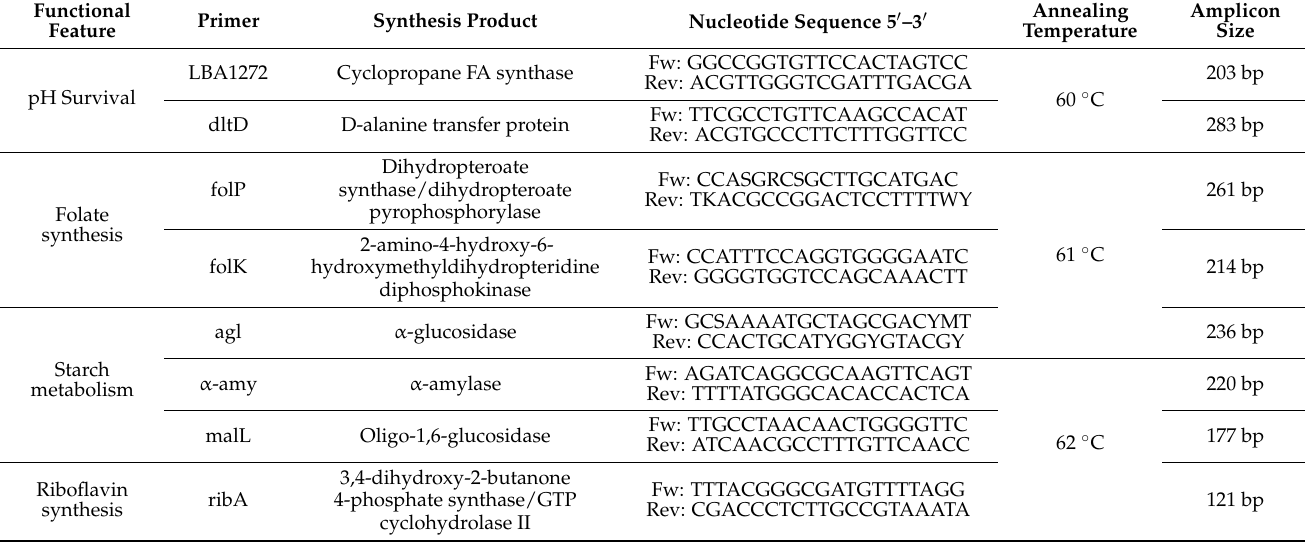
Table 4. Primers used for functional gene detection